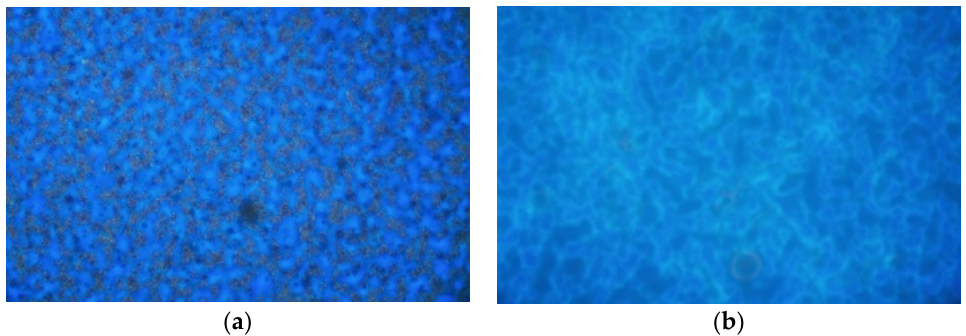
Figure 12. Fluorescent micro-structure of WE/A with 35% WER ( a ) 1 h; ( b ) 48 h.